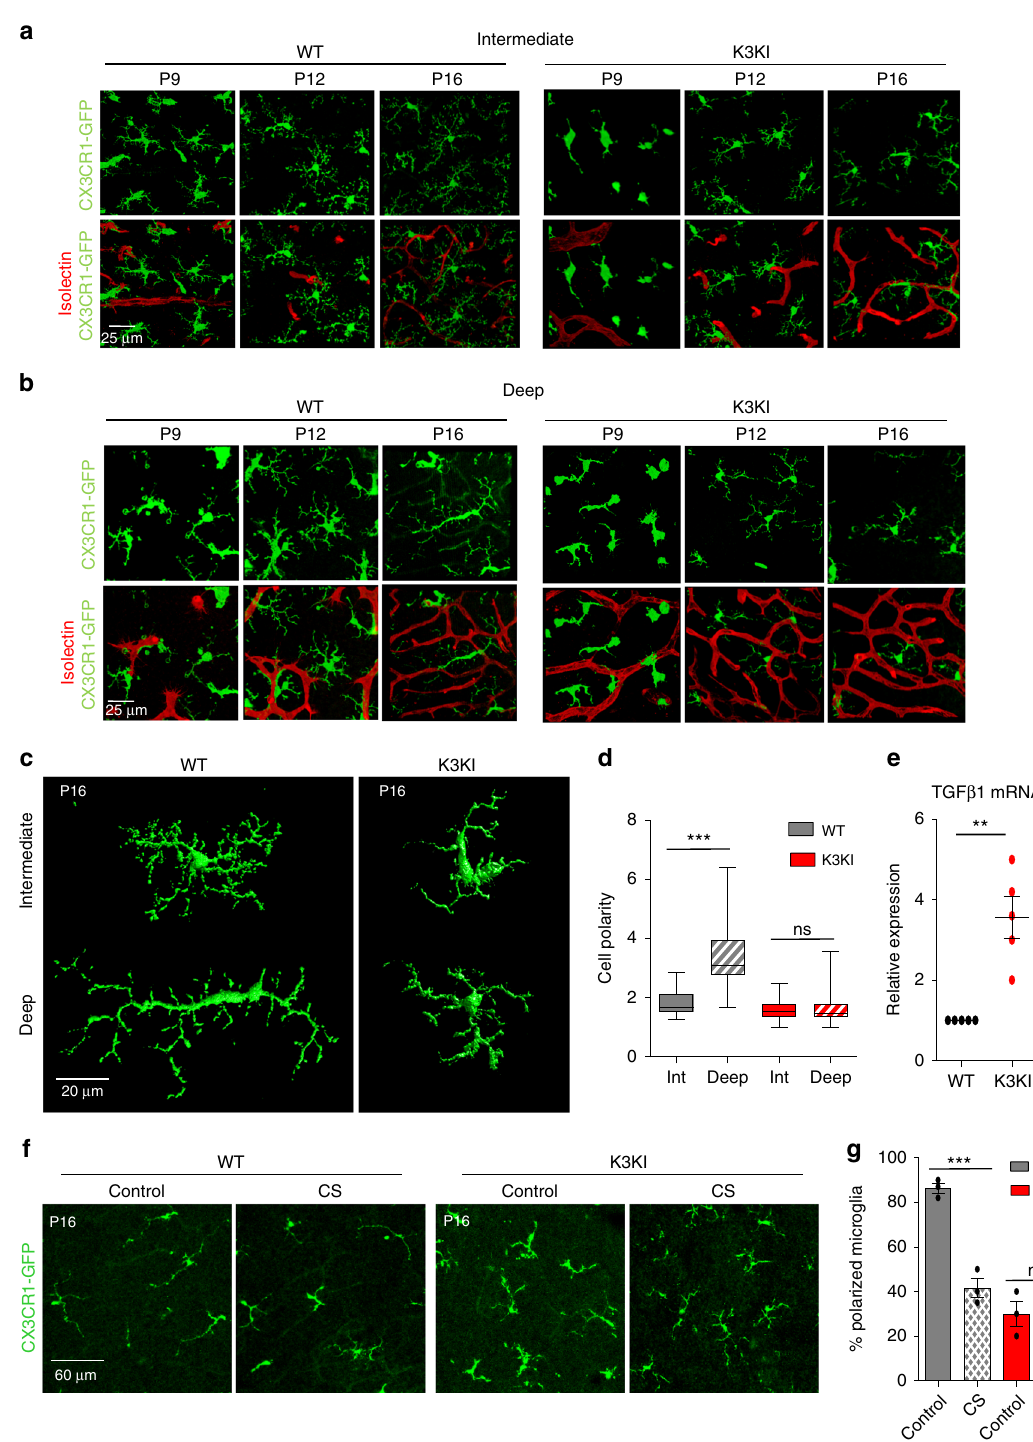
>95% of microglia with pexidartinib (Fig. 6a, b) before the vascular layers were completed. Microglial depletion normal- ized vascular density in K3KI retinas to levels observed in WT retinas (Fig. 6a, c). Next, to ultimately prove that it is microglial TGF β 1 overexpression that caused misguided vasculature in CX3CR1-cre;K3 f/f and K3KI mice, we generated a double knockout of Kindlin3 and TGF β 1 in microglia, CX3CR1-cre; K3 f/f /TGF β 1 f/f mice. Downregulation of TGF β 1 signaling in endothelium of CX3CR1-cre;K3 f/f /TGF β 1 f/f mice was con fi rmed by dramatically reduced pSMAD3 staining (Fig. 6d, e) and